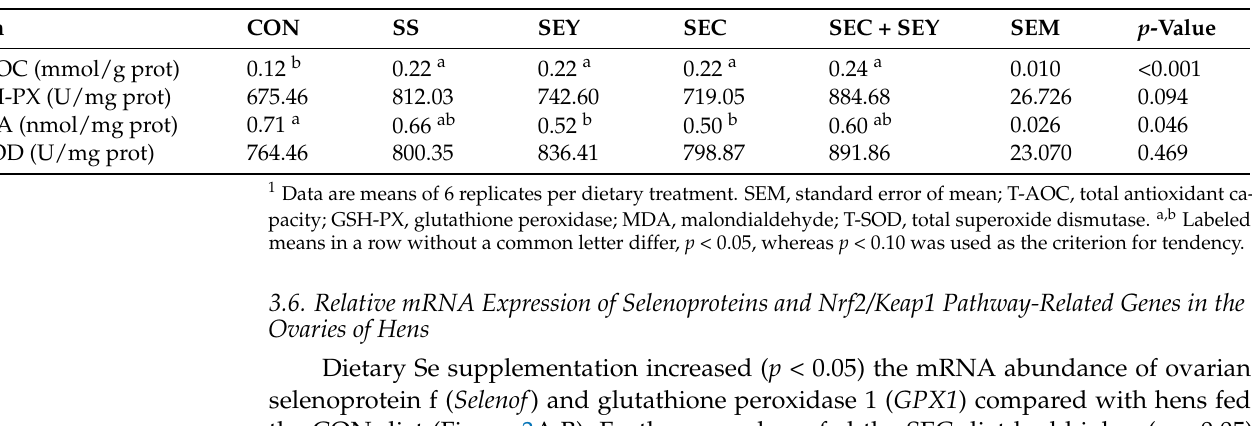
Table 6. Effects of different Se sources on ovarian antioxidant capacity in laying hens 1